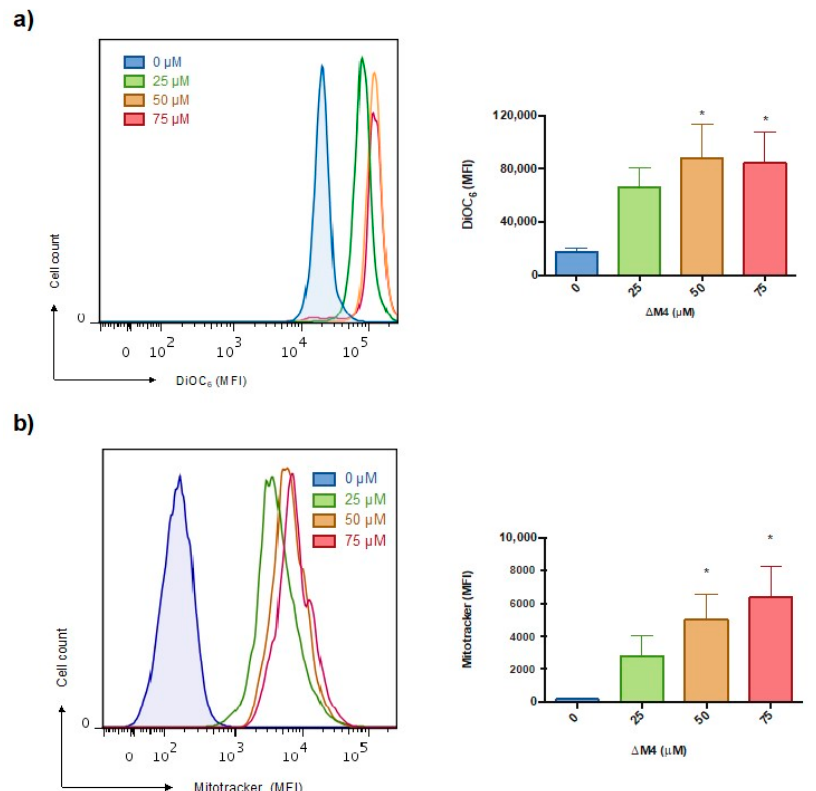
Figure 4. Effects of ∆ M4 on the mitochondrial integrity of A375 cells. Cells were treated with different concentrations of ∆ M4 for 24 h and subsequently analyzed by flow cytometry. ( a ) Mitochondrial membrane polarization was evaluated with DiOC 6 uptake; the left panel shows a representative histogram for the increase in dye caption, and the bar graph expresses the mean ± SEM of MFI obtained in three independent experiments. ( b ) Mitochondrial ROS production quantification; the left panel shows a representative histogram for the increase in the fluorescent intensity of Mitotracker in A375 mitochondrion, and the bar graph expresses the mean ± SEM of MFI obtained in three independent experiments. One-way ANOVA revealed the difference with respect to non-treated cells, where * p ≤ 0.05.